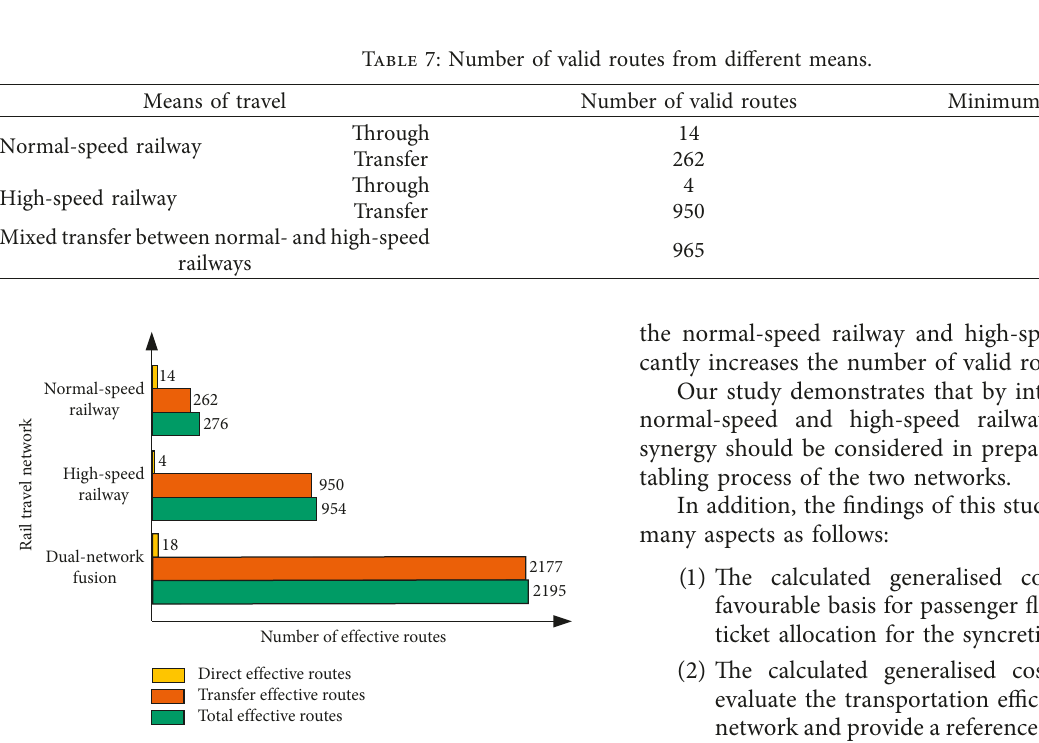
Figure 8: Comparison of the number of valid routes between single network and syncretic railway